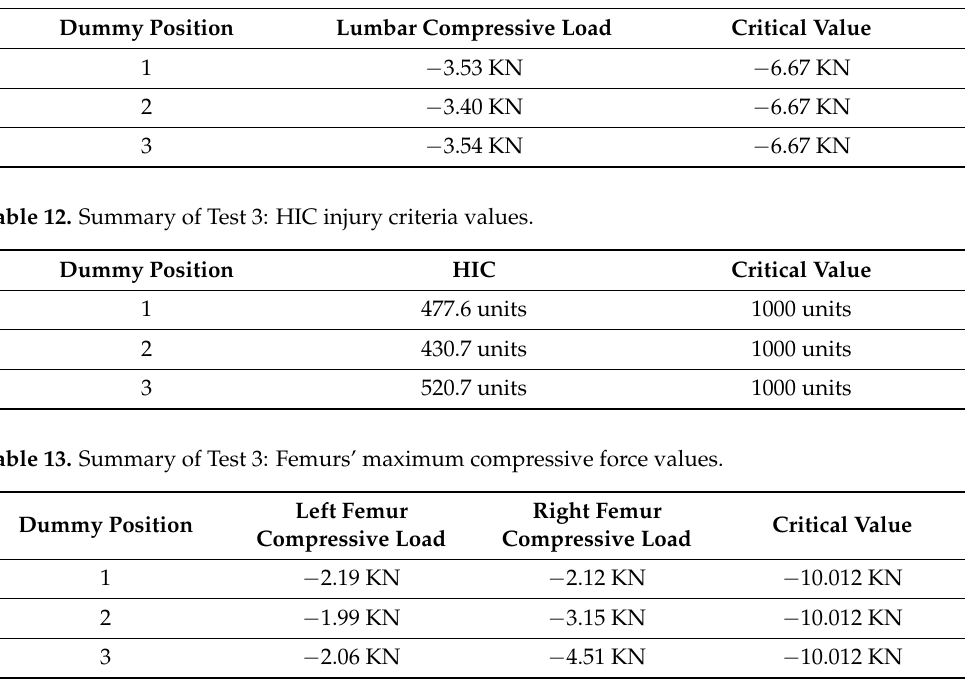
Table 11. Summary of Test 1: Lumbar maximum compressive force values.